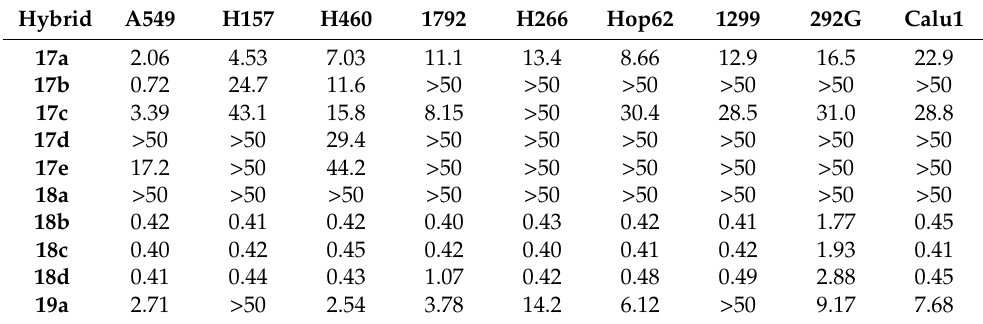
Table 3. The in vitro anticancer activities of the hybrid nitrates 17 – 19a in nine human lung cancer cell lines (IC 50 in µ M) [42].